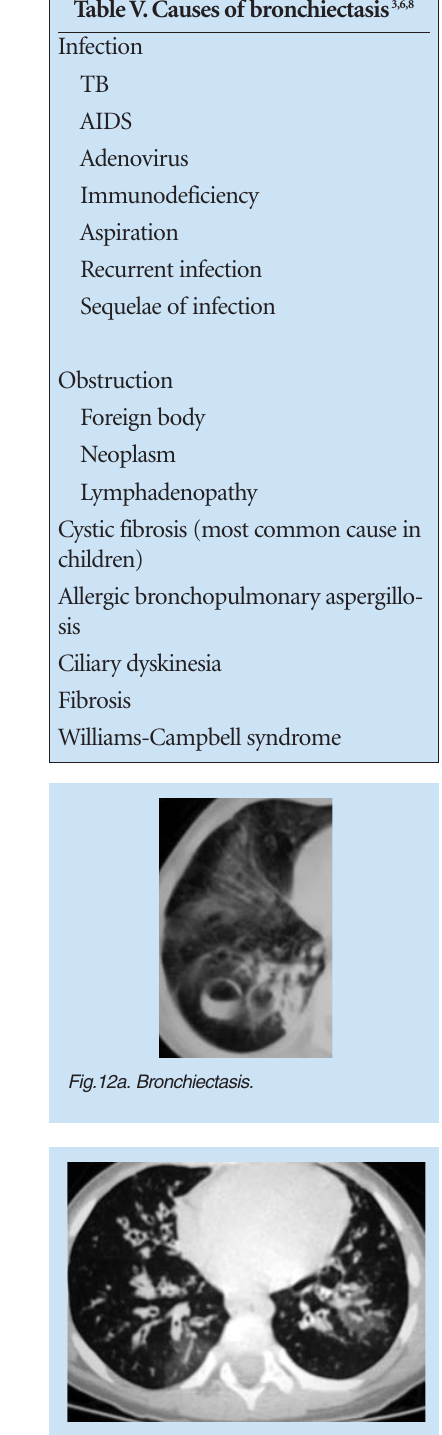
Fig. 11a. Architectural distortion